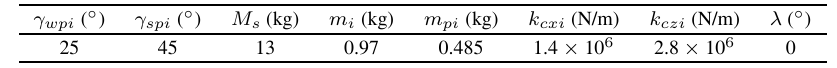
Table 1 Parameters of the example system